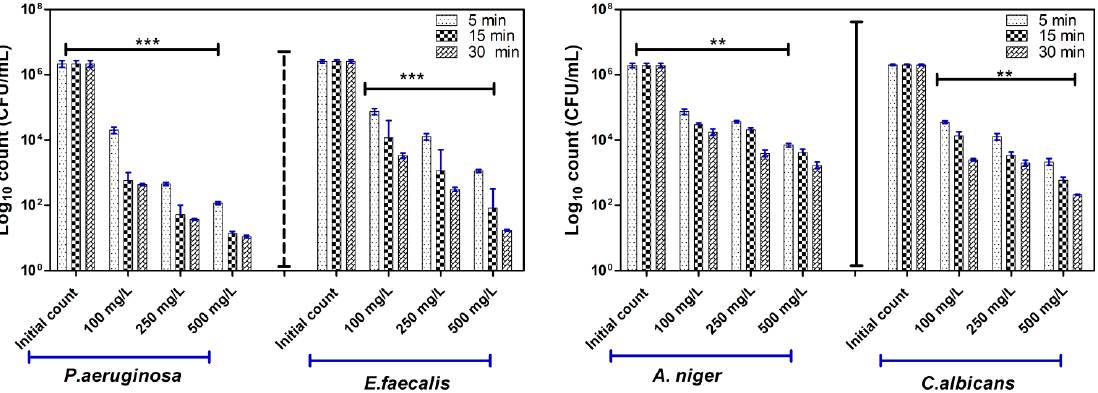
Figure 9. Colony-forming unit and MIC values of AgNPs-1@NFs against human-associated pathogens including P. aeruginosa, E. faecalis, C. albicans, and A. niger . The remaining viable cell populations at various time intervals of 5, 15, and 30 min are shown. Two-way analysis of variance ( ANOVA ) states, * indicates moderate correlation (p ≤ 0.01), ** indicates high correlation (p ≤ 0.001), *** indicates high correlation ( p ≤ 0.0001).